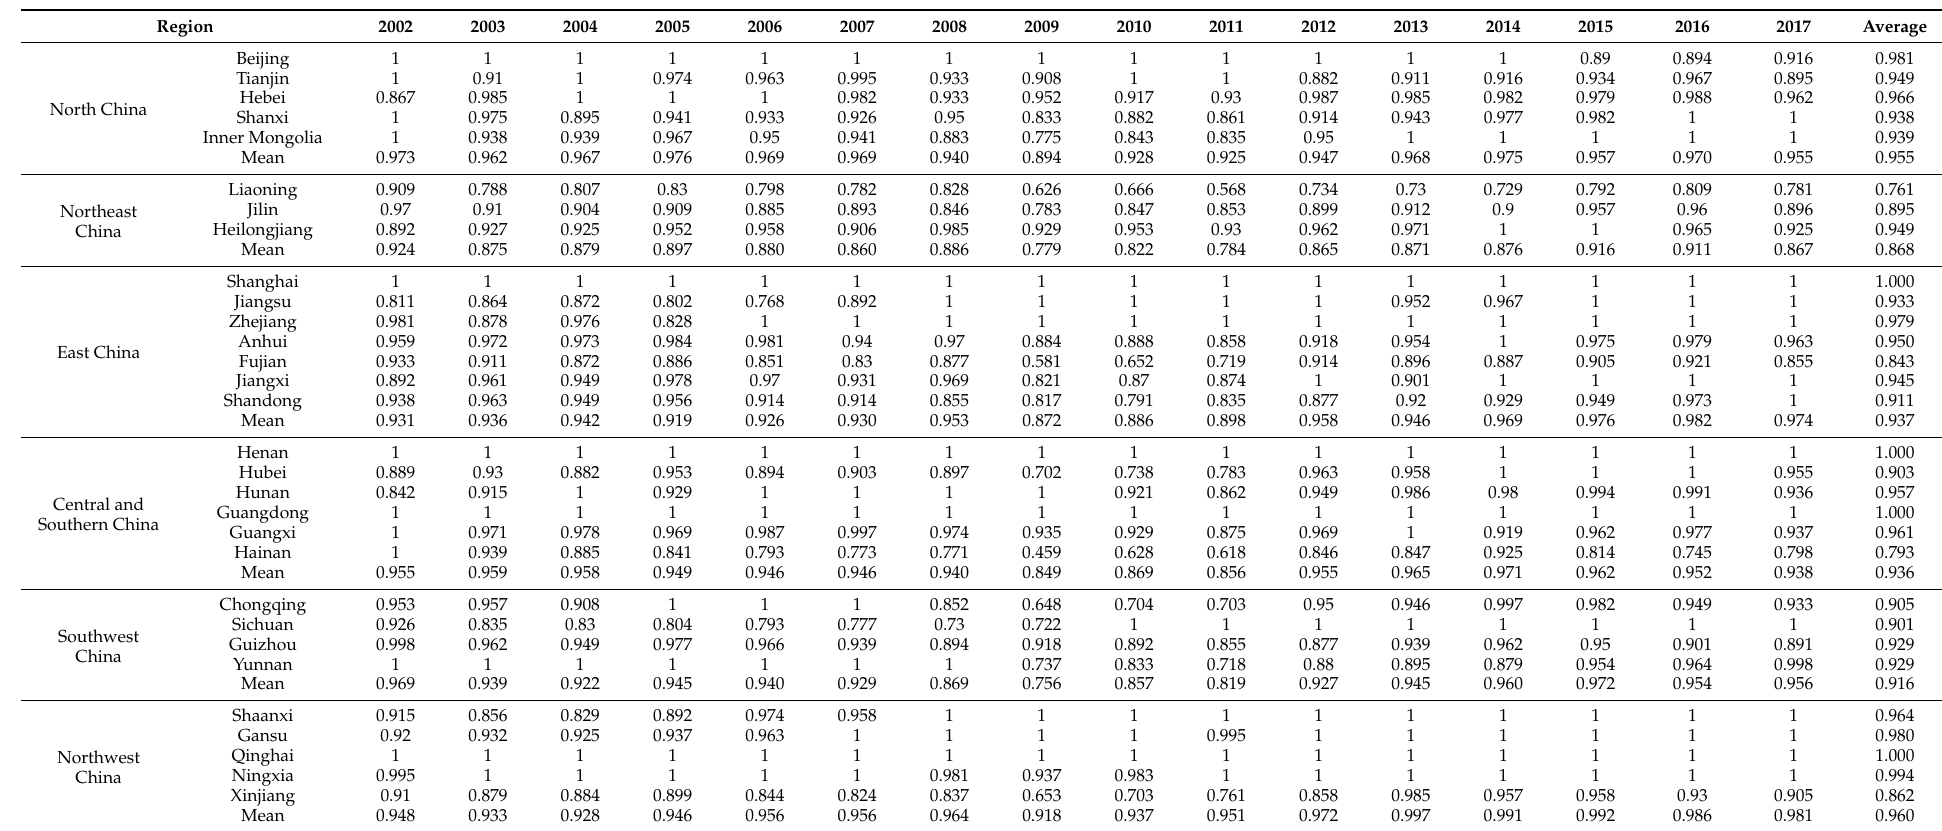
Table 3. The third stage pure technical efficiency (PTE)